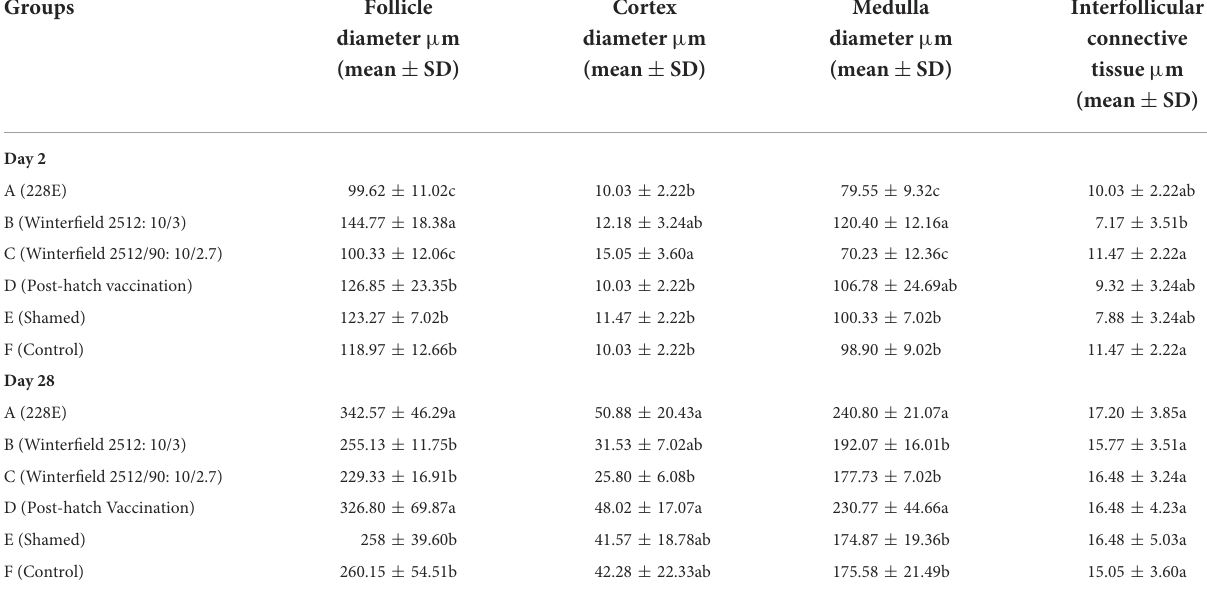
TABLE 9 Histomorphometery of bursa of Fabricius of the White Leghorn chicks administered live IBD vaccines in ovo and post-hatch period at days 2 and 28 of age.